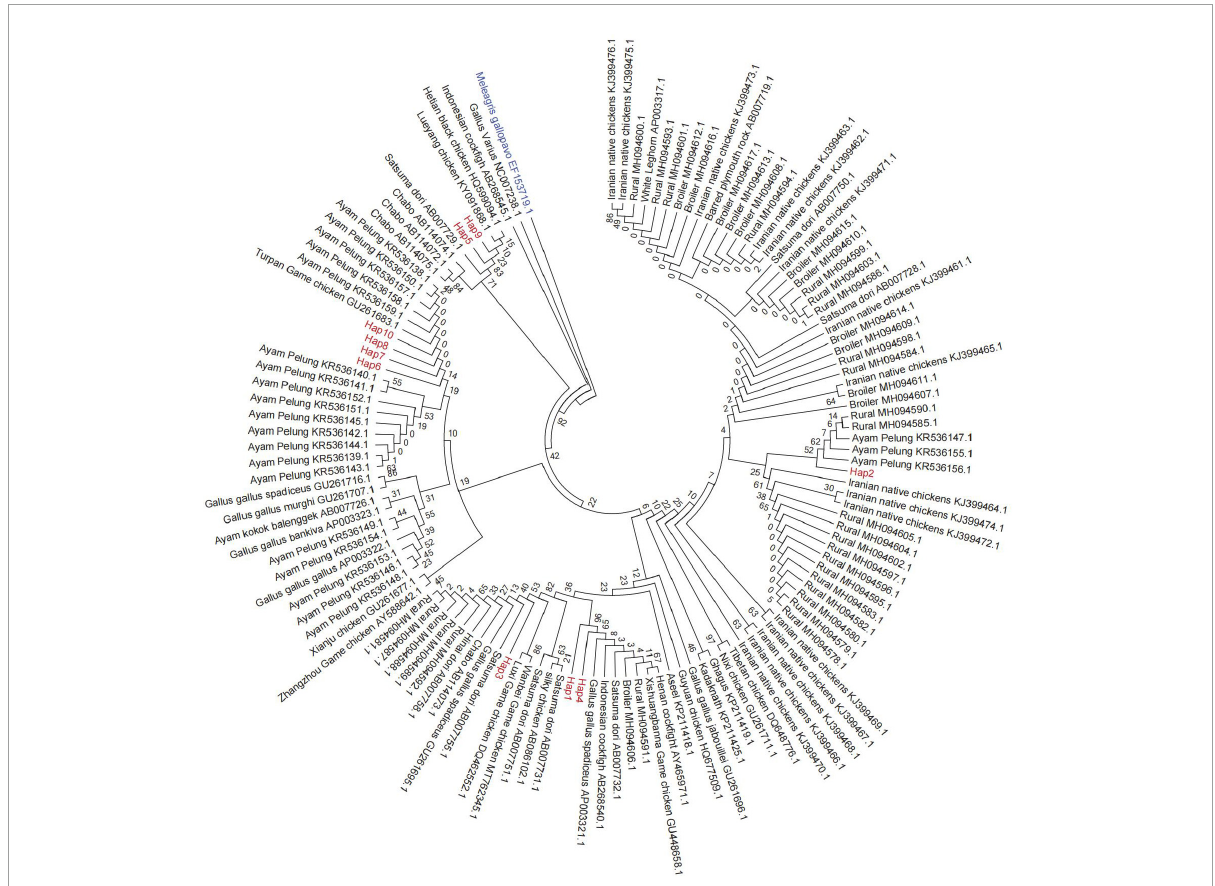
FIGURE5 The phylogenetic relationships between the Anjian chicken and 36 other breeds. Anjian chicken haplotypes are highlighted in red, and a breed of turkey (EF153719.1) was selected as the outgroup. The bootstrap value percentage is displayed above the branch.